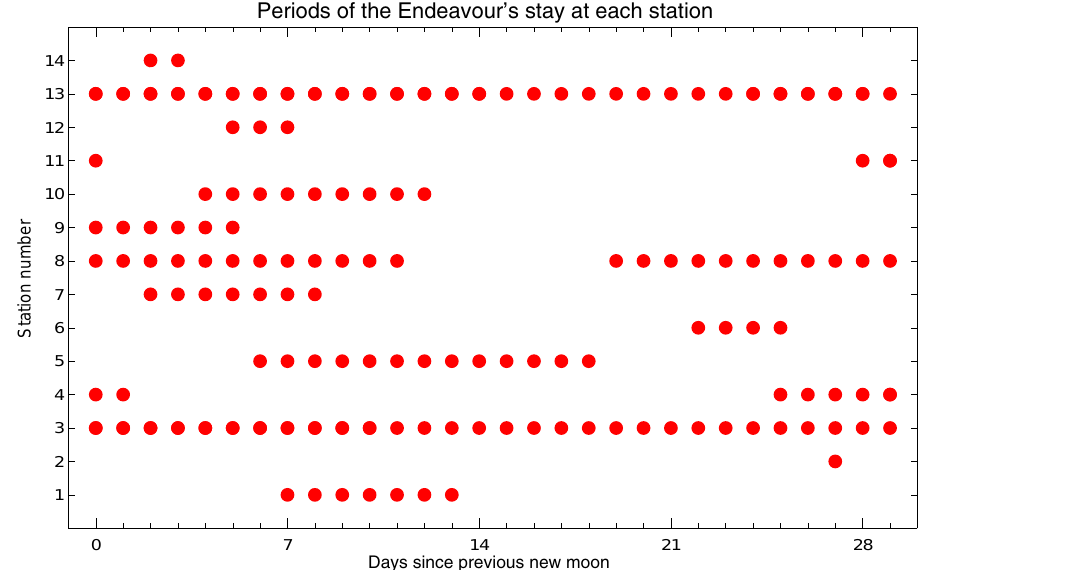
Figure 2. A schematic summary of the periods of the Endeavour ’s stay at each station in Table 1 expressed as days since the last new moon at